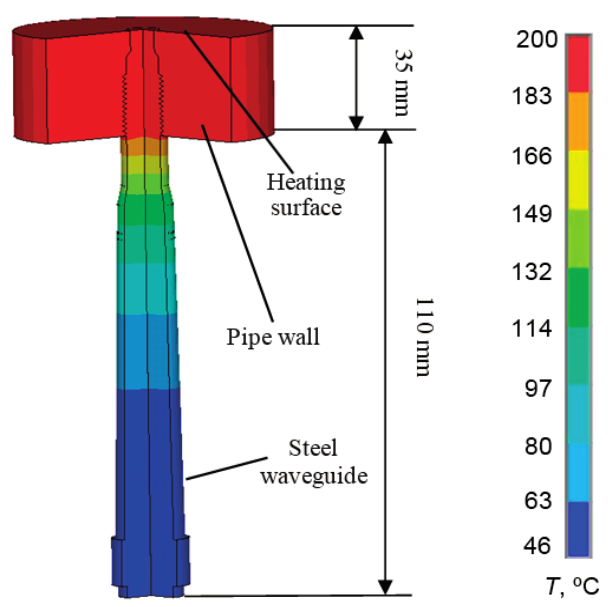
Figure 4. Temperature distribution in the AISI 316 steel